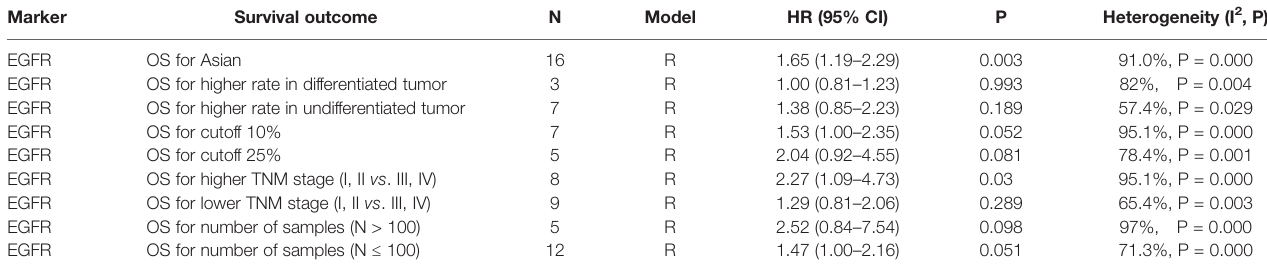
TABLE 3 | Subgroup analysis of relationship between EGFR and OS.